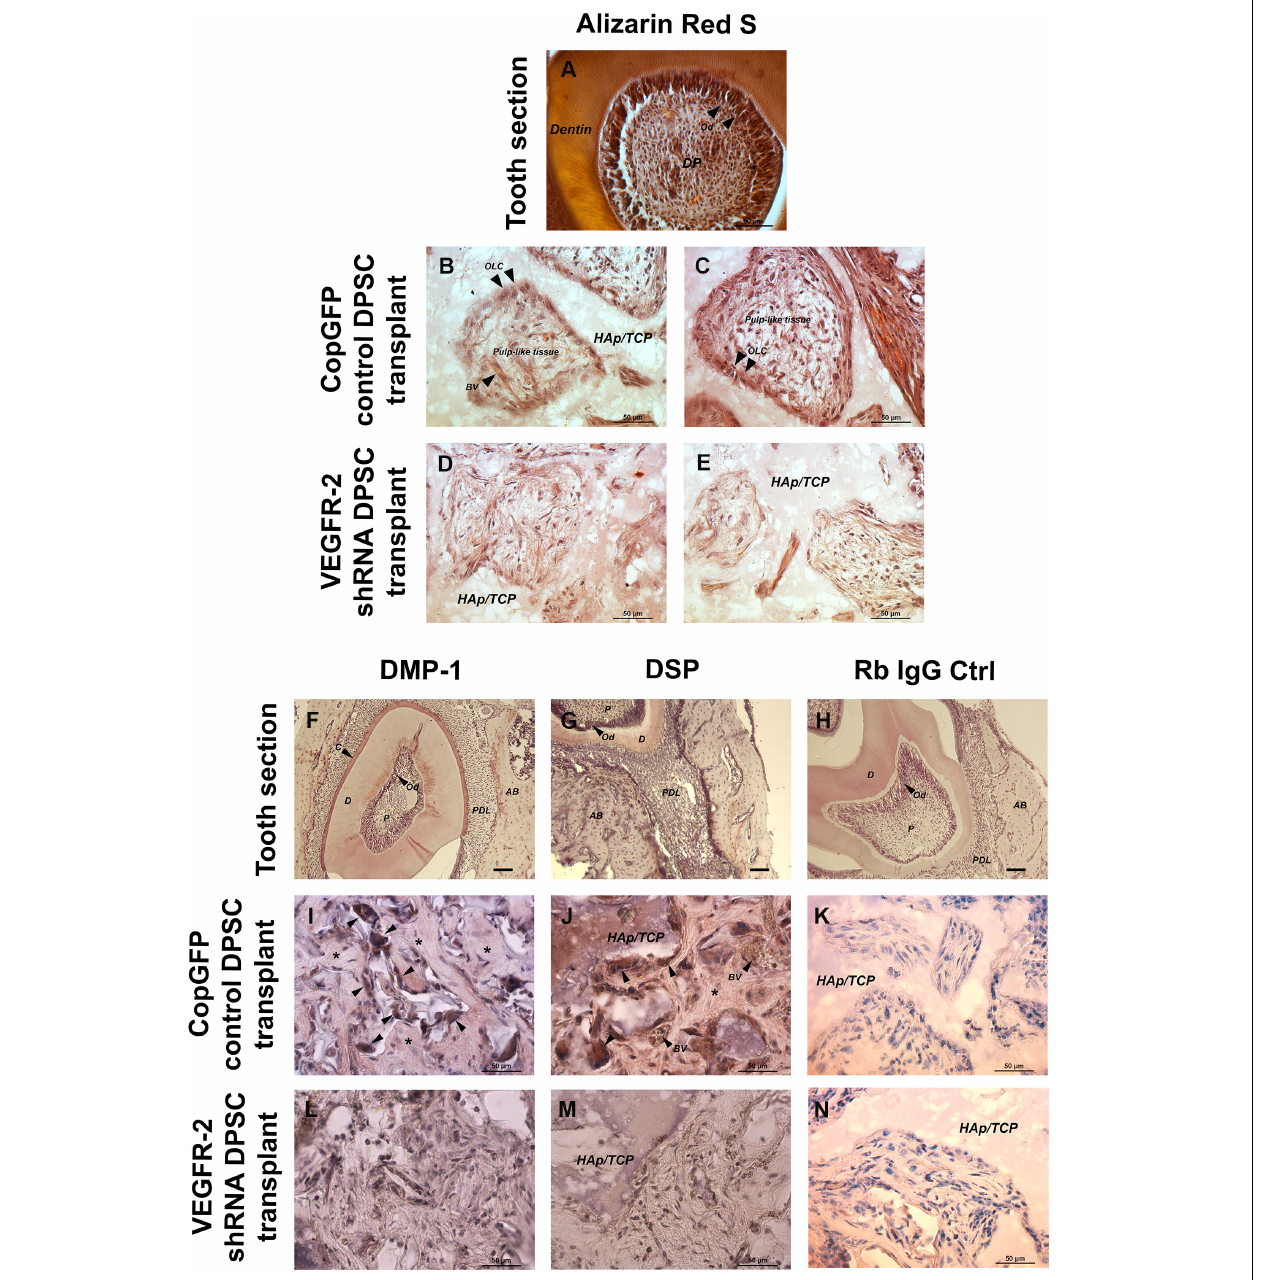
FIGURE 7 | In vivo transplantation of CopGFP control and VEGFR-2 shRNA DPSCs by Alizarin Red S staining and immunohistochemistry. Alizarin Red S staining was conducted to confirm the mineralized tissues, dental structures and morphology of CopGFP DPSC transplants and VEGFR-2 shRNA DPSC transplants. The cross-section of murine tooth was used as a positive control for Alizarin Red S staining. The positive area of Alizarin Red S showed in dentin, odontoblasts and some dental pulp regions (A) . A CopGFP control DPSC transplant revealed positive staining of fibrous structure surrounding HAp/TCP with elongated and polarized odontoblast-like cells (OLC) (arrowheads). Some positive odontoblast-like cells (OLC) (arrowheads) running perpendicular to HAp/TCP and pulp-like tissues with blood capillaries were seen in CopGFP DPSC transplants (B,C) . VEGFR-2 shRNA DPSC transplants only showed diffuse unpatterned cell arrangement with disorganized connective tissue (D,E) . Immunohistochemistry of anti-DMP-1 and anti-DSP staining was also conducted to determine the specific dentin protein expression in the transplant tissues. The tooth sections were used as a positive control. The expression of DMP-1 and DSP was seen in dentin, cementum and alveolar bone. Both dentin matrices were very strong in the odontoblast cell layer (F,G) . The CopGFP control DPSC transplants revealed the strongly positive anti-DMP-1 and anti-DSP staining in odontoblast-like cells (OCL) (arrowheads) (I,J) . Its matrices were slightly stained for both markers (asterisks). The VEGFR-2 shRNA DPSC transplants showed the negative anti-DMP-1 and anti-DSP staining (L,M) . The Rabbit IgG control (Rb IgG Ctrl) was used as a negative control to confirm the specificity of antibody (H,K,N) . AB; alveolar bone, C; cementum, D; dentin, HAp/TCP; hydroxyapatite/tricalciumphosphate, OLC; odontoblast-like cells, P; Pulp, PDL; periodontal ligament. Scale bars indicate 50 µ